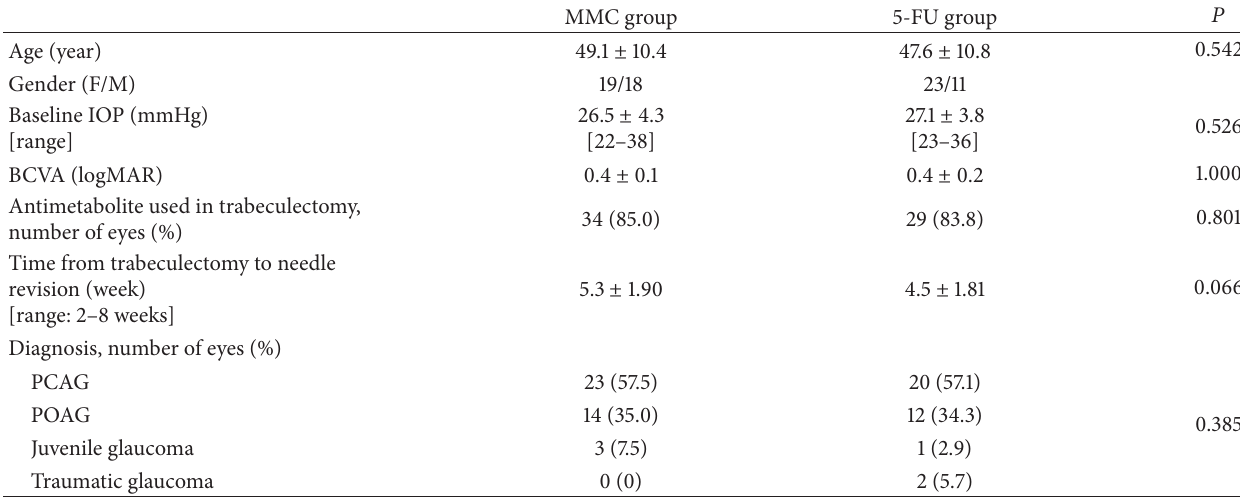
Table 1: Patient demographic and clinical characteristics of the